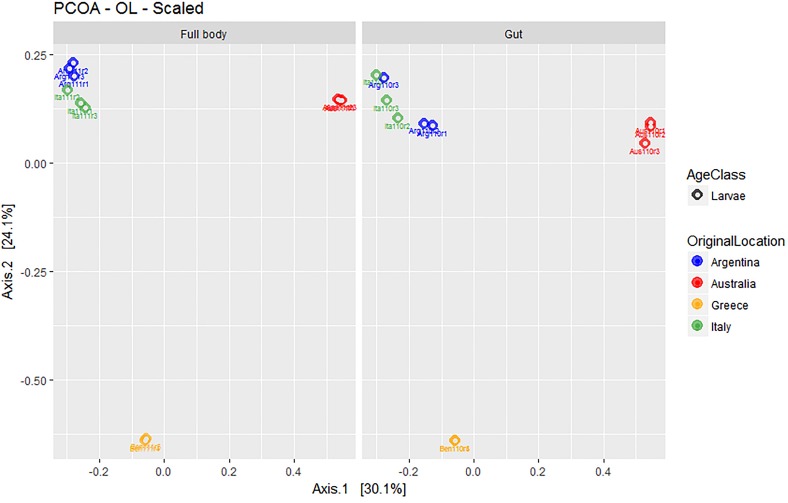
Multivariate ordination (PCOA) of gut microbial assemblages in ethanol preserved third instar larvae of C. capitata with different origin (colony – Greece, colony – Argentina, colony – Australia, wild – Italy). For clarity, the same PCOA is represented twice, either with full body (left) or gut-dissected samples (right) indicated. Colors represent original origin of samples (blue: Argentina, red: Australia, yellow: Greece, green: Italy).